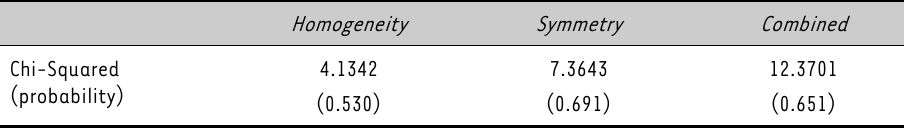
Wald test for homogeneity, symmetry and combined for USA tourists Homogeneity Symmetry